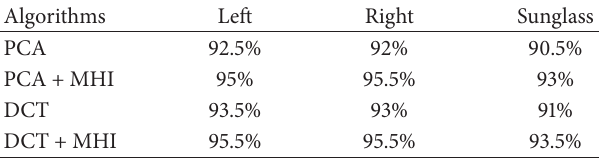
Table 2: Results of the third stage.